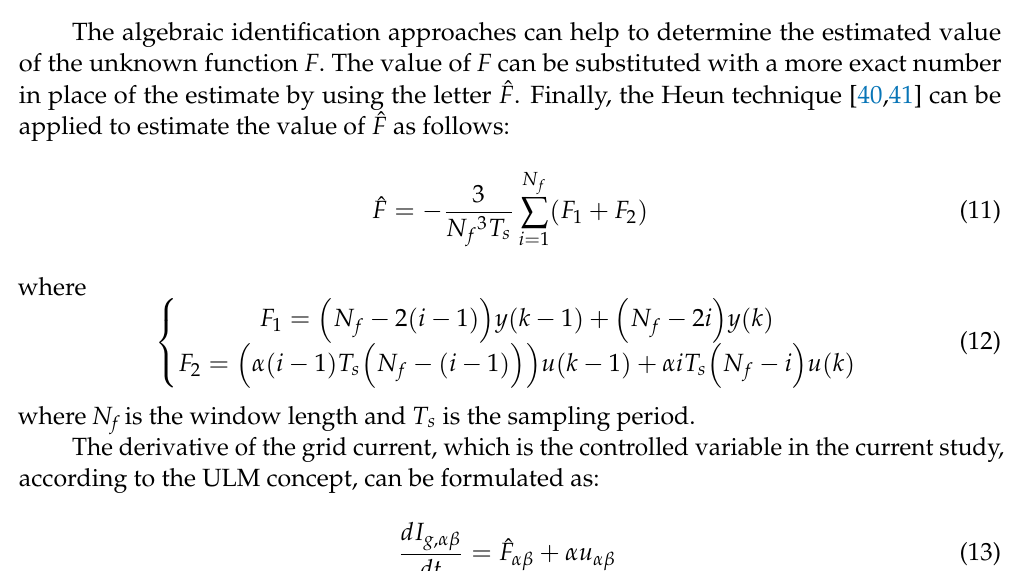
Figure 5. Basic implementation of the ULM.